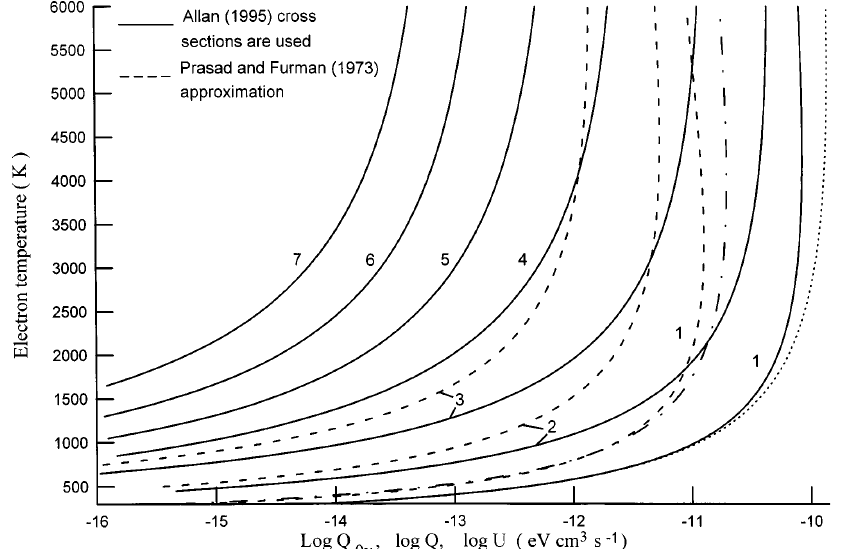
Fig. 1. Comparison of Q calculated by use 0v of the energy integrated cross sections of Allan (1995) ( solid lines ) and Linder and Schmidt (1971) ( dashed lines ) for the O 2 vibrational levels v (cid:136) 1 ; 2 ; ... 7 (cid:133) curves 1 ; 2 ; ... 7 (cid:134) : Dotted line is P 7 Q (cid:133) T e (cid:134) (cid:136) Q 0 v (cid:133) T e (cid:134) calculated in this study v (cid:136) 1 by using the energy integrated cross sections of Allan (1995). Dashed-dotted line is P 4 U (cid:133) T e (cid:134) (cid:136) Q 0 v (cid:133) T e (cid:134) given by Prasad and v (cid:136) 1 Furman (1973) and based on the O 2 integral vibrational cross sections of Linder and